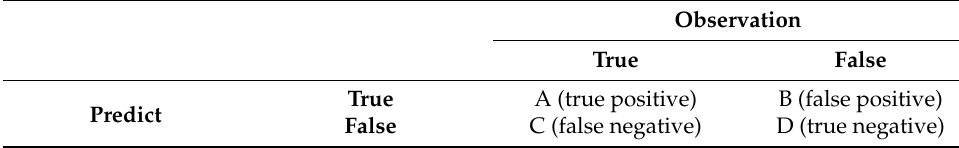
Table 3. Contingency table for identifying the extreme rainfall events. Elements A, B, C, and D indicate true positive, false positive, false negative, and true negative, respectively.